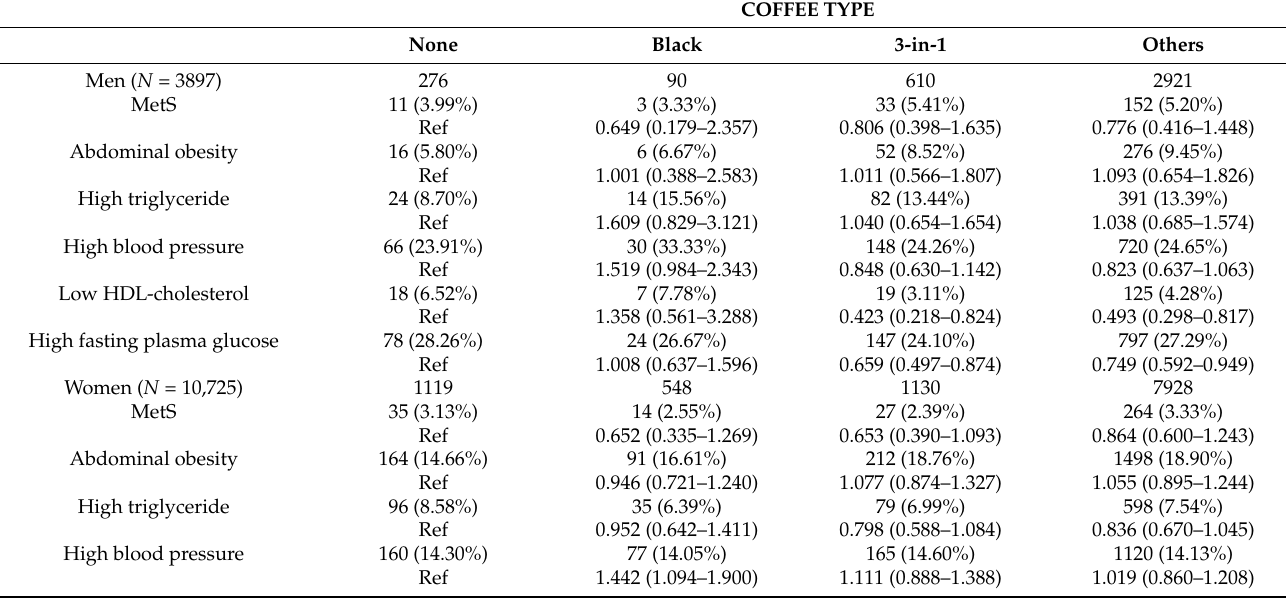
Table 3. Association between coffee type and MetS and its five components (reference group: non–coffee consumers) 1